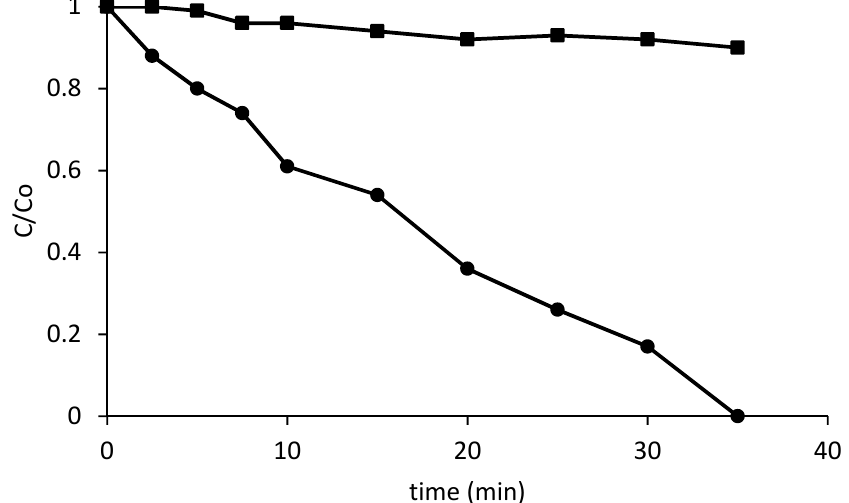
Figure 1. Plot of the relative concentration pentachlorophenol (PCP) decrease versus time when irradiated in a solar simulator without ( (cid:8) ) and with ( (cid:4) ) a Pyrex ® filter. Table 1. Removal of pentachlorophenol (PCP) (1 mg / L) by photo-Fenton driven under simulated sunlight without Pyrex filter at di ff erent pH with or without HLS. The t 50% are given in min. pH = 2.8 pH = 5 pH =